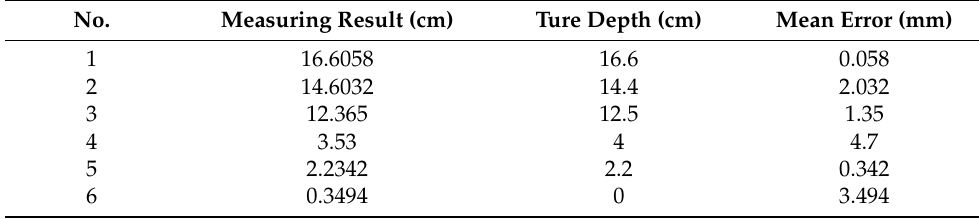
Table 2. Measuring results and mean errors of water